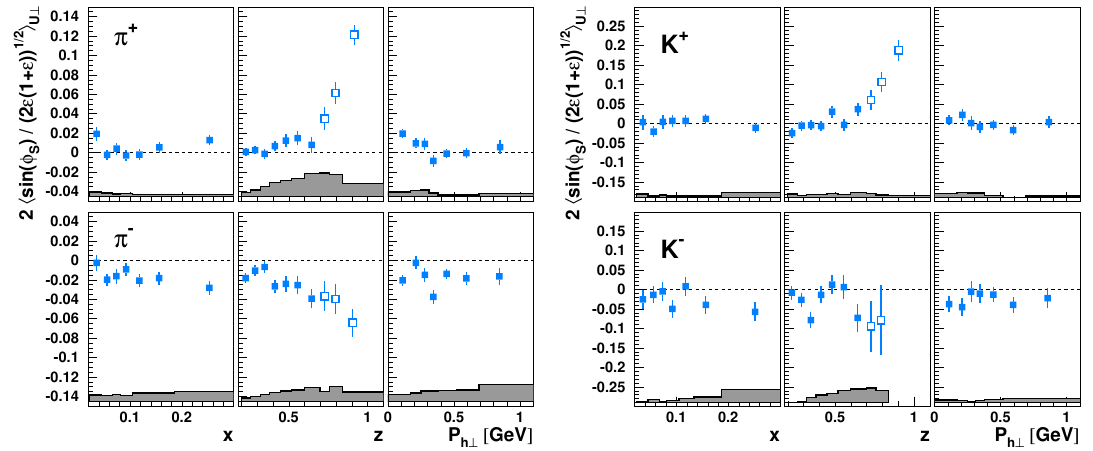
p Figure 25 . The 2 h sin( φ S ) / 2 (cid:15) (1+ (cid:15) ) i h amplitudes for charged mesons (left: pions; right: kaons) U ⊥ presented either in bins of x , z , or P h ⊥ . Data at large values of z , marked by open points in the z projection, are not included in the other projections. Systematic uncertainties are given as bands, not including the additional scale uncertainty of 7.3% due to the precision of the target-polarization